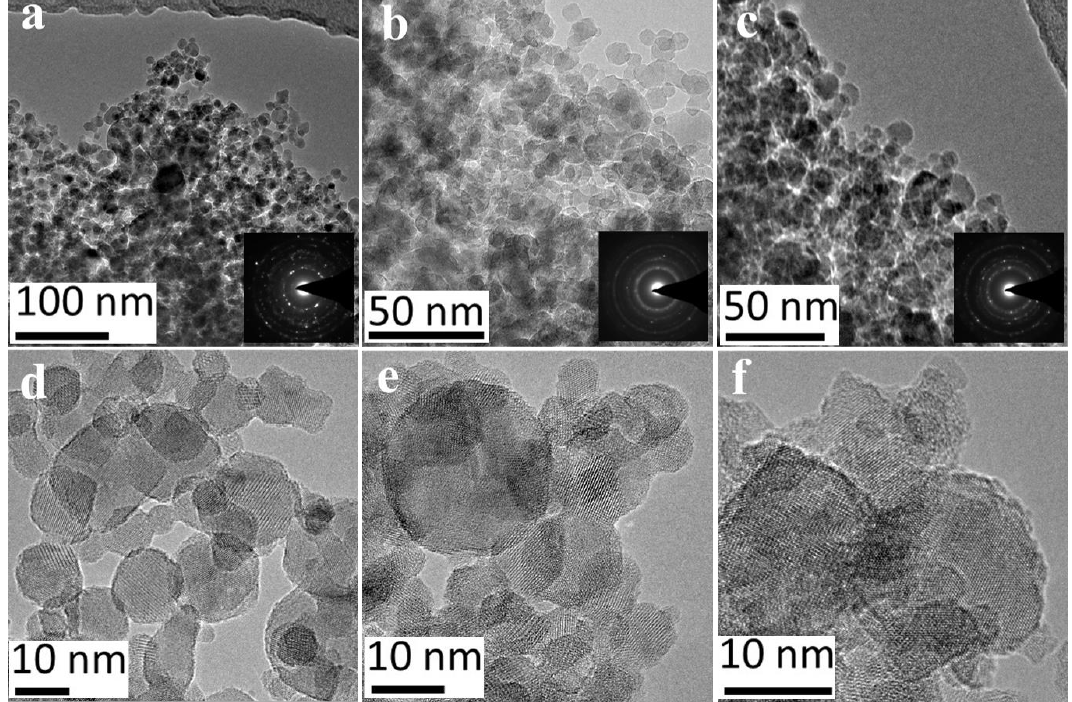
Figure 3. TEM ( a – c ) with SAED pattern (inset) and HRTEM ( d – f ) for samples with an Fe/Ti ratio of: ( a , d ) 0%, ( b , e ) 3%, and ( c , f ) 10%.